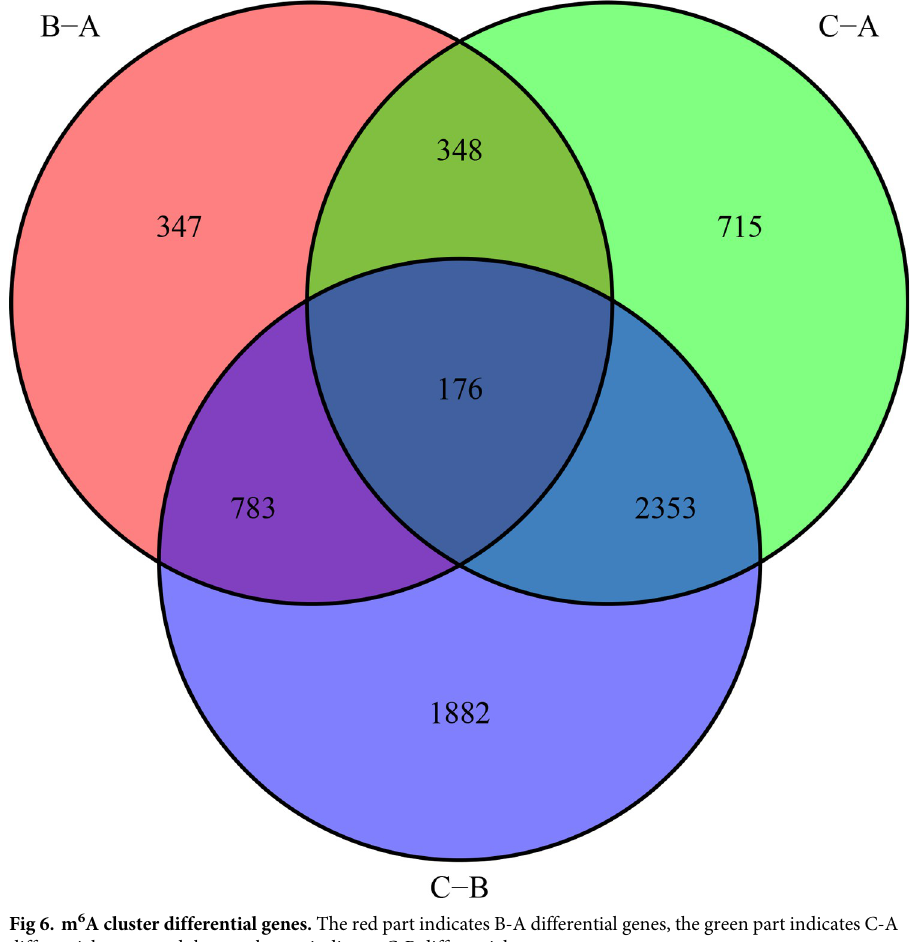
Fig 6. m 6 A cluster differential genes. The red part indicates B-A differential genes, the green part indicates C-A differential genes, and the purple part indicates C-B differential genes.